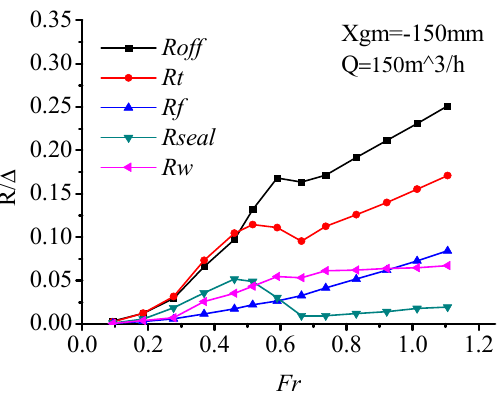
Δ Δ ∆ = 145 kg, Q = 150 m 3 / h. =145kg, Q =150m 3 /h. =145kg, Q =150m 3 /h. Figure 12. Resistance components Comparison under condition